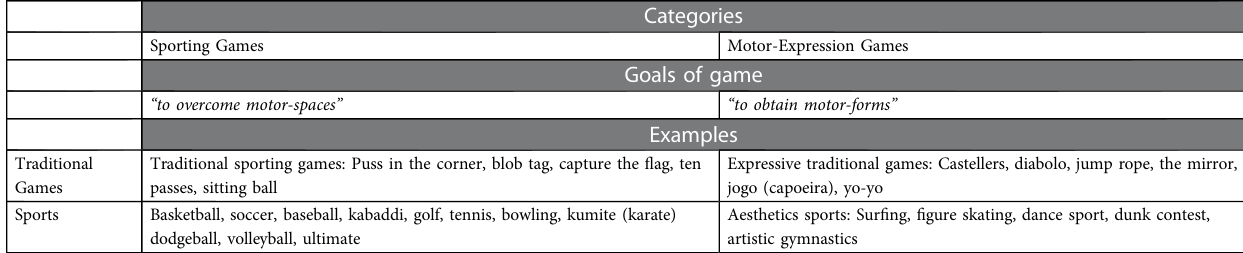
TABLE 2 The two large categories of sports and traditional games according to their goals of game, and some examples.